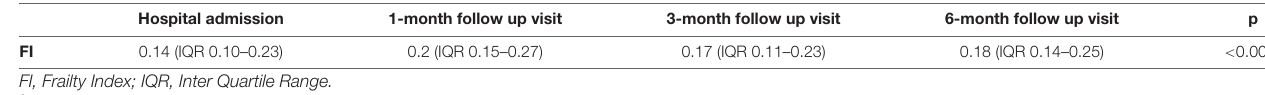
TABLE 7 | Variations of the frailty index during the follow-up in a subgroup of 78 patients.